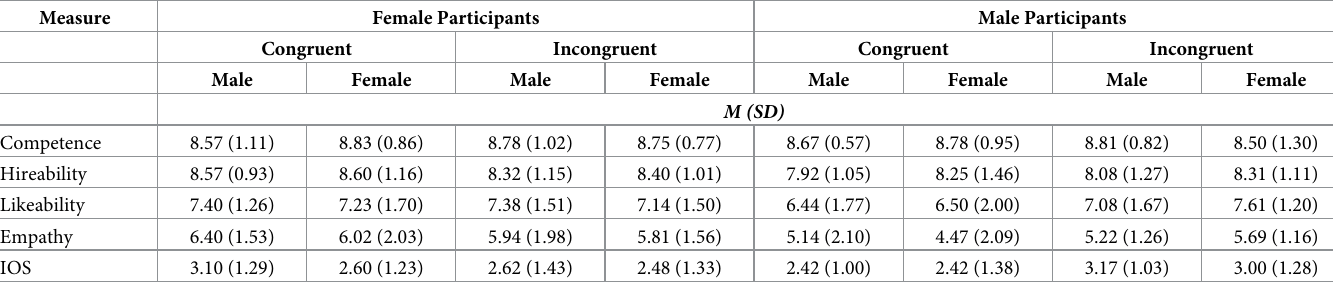
Table 3. Summary of candidate ratings by experimental group in Study 1.